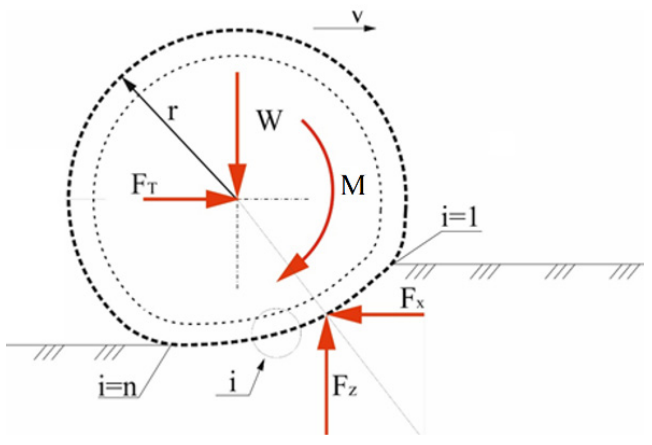
Figure 6. The forces acting on the wheel on soft surface: i—treat element; n—last treat elements in contact with ground number; W—vertical load of wheel; F T —pulling force [16].